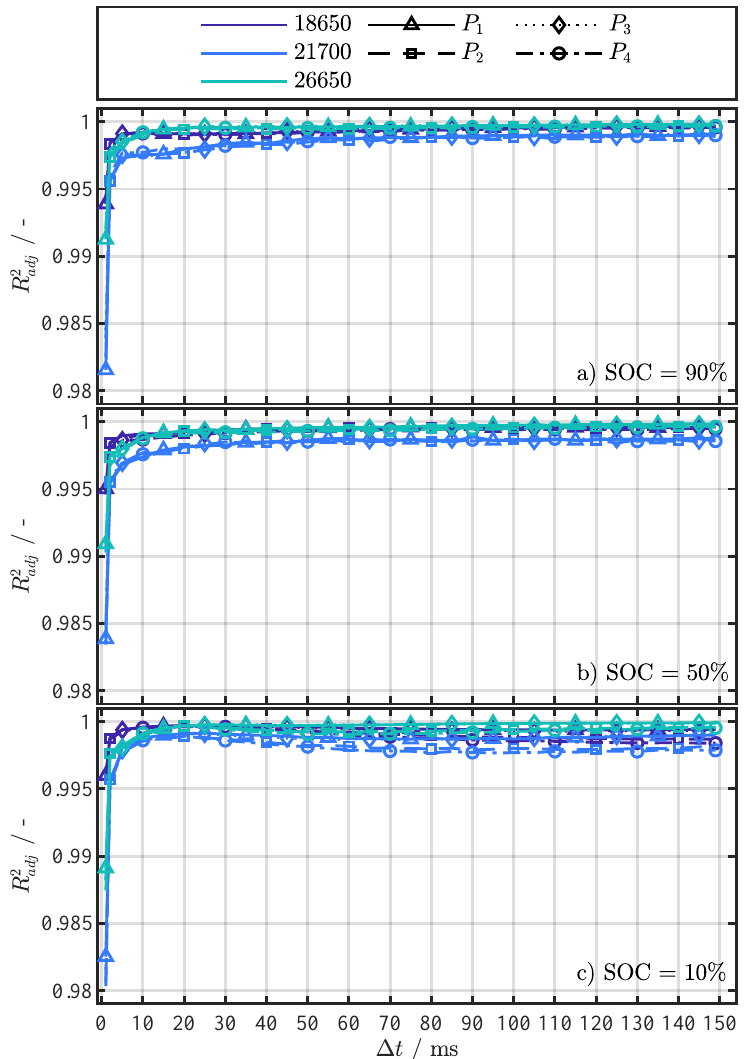
Figure A5. R 2 results for fitting Equation (4) for each investigated cell format and the four different adj pulse current types ( P 1 to P 4 ) at the SOCs 90% ( a ), 50% ( b ), and 10% ( c